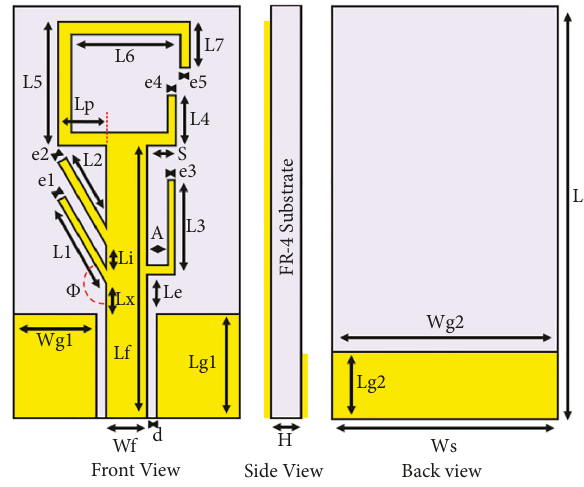
Figure 1: Geometry of multi-band antenna.